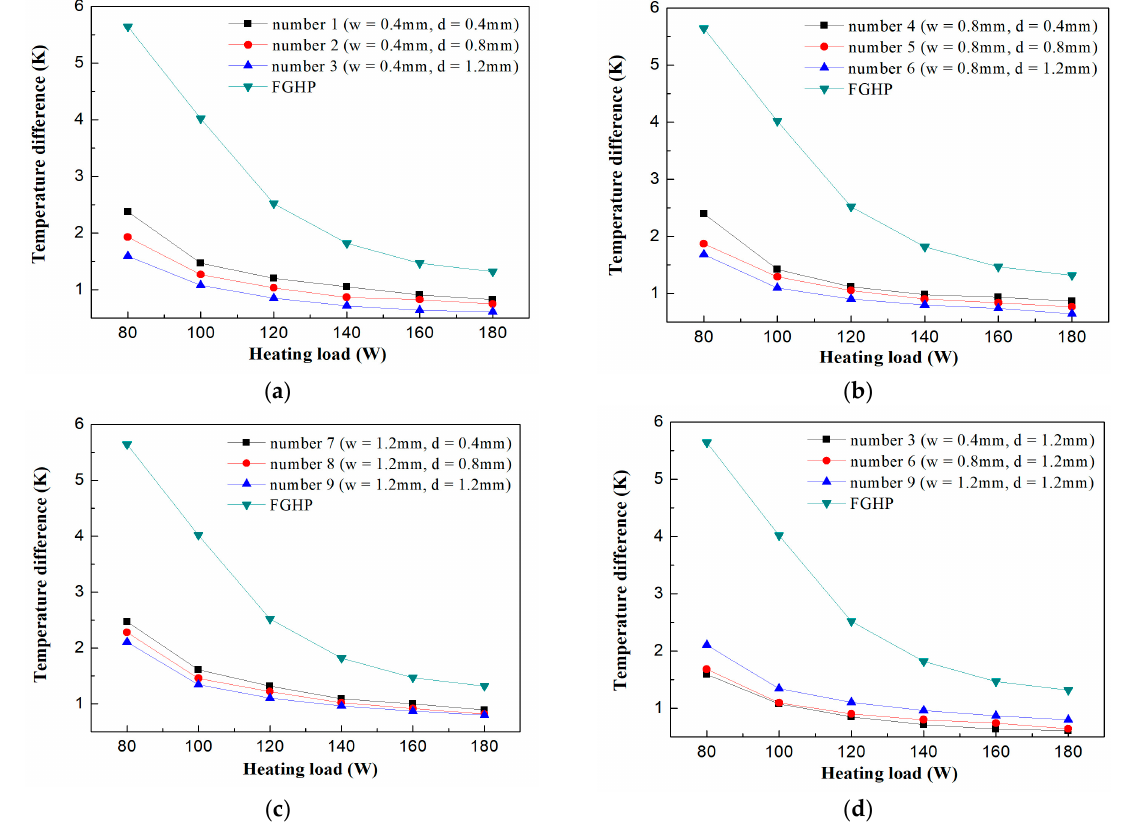
Figure 4. The temperature difference of the FMGHPs and FGHP at different heating loads: ( a ) FMGHPs 1–3 and FGHP; ( b ) FMGHPs 4–6 and FGHP; ( c ) FMGHPs 7–9 and FGHP; ( d ) FMGHPs 3, 6, 9 and FGHP.